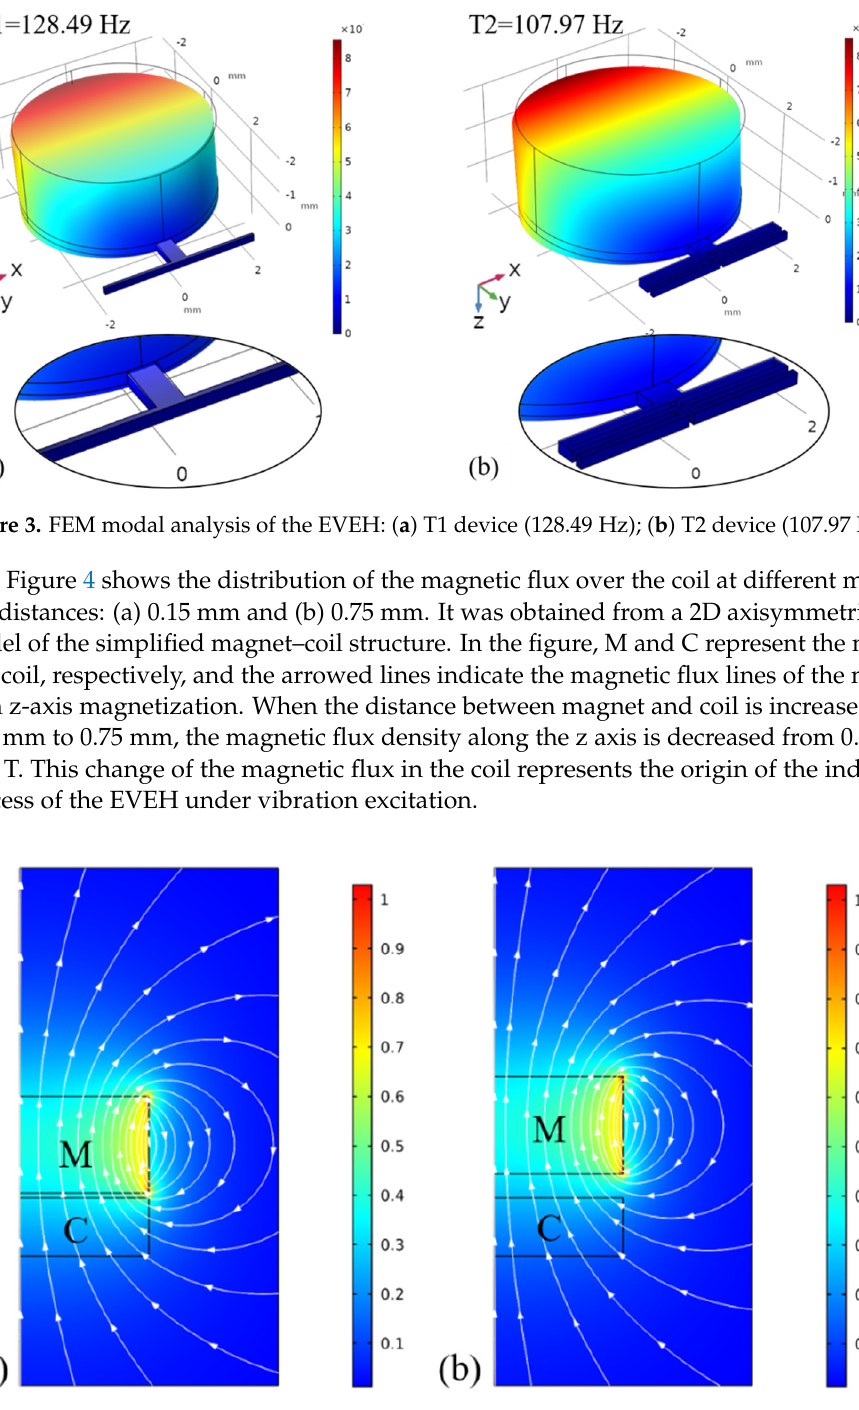
Figure 4. The magnetic flux of the magnet–coil structure based on a 2D axisymmetric FEM model at different magnet–coil distances: ( a ) 0.15 mm; ( b ) 0.75 mm.